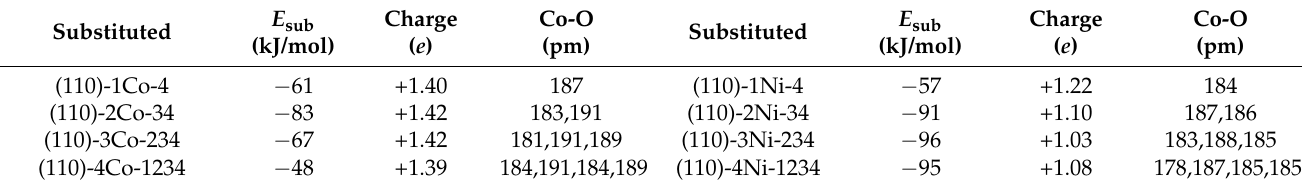
Table 1. The E sub , average Me − O bond distances and average Bader charges of substituted Me atoms for the most stable substituted structures.